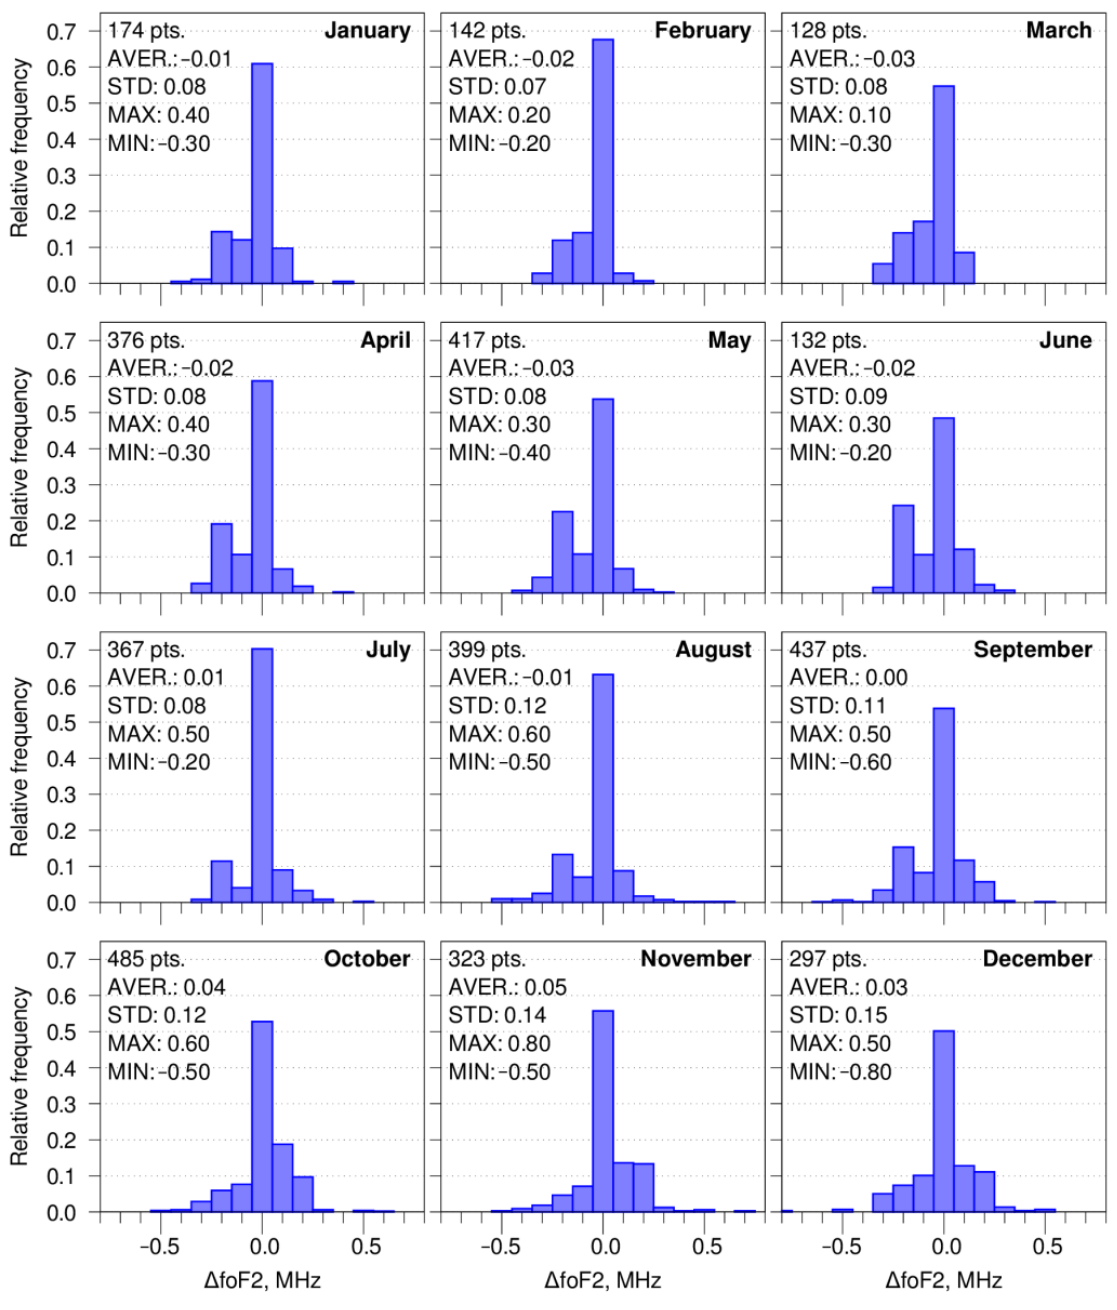
Figure 9. Distribution of the differences in critical frequency Δ foF2 by month during the 2021.